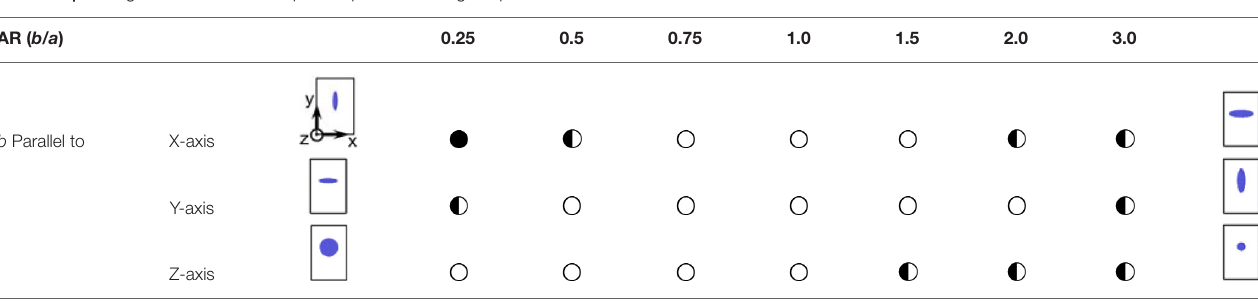
TABLE 1 | Cutting extent for various ellipsoidal particles during the particle–GB